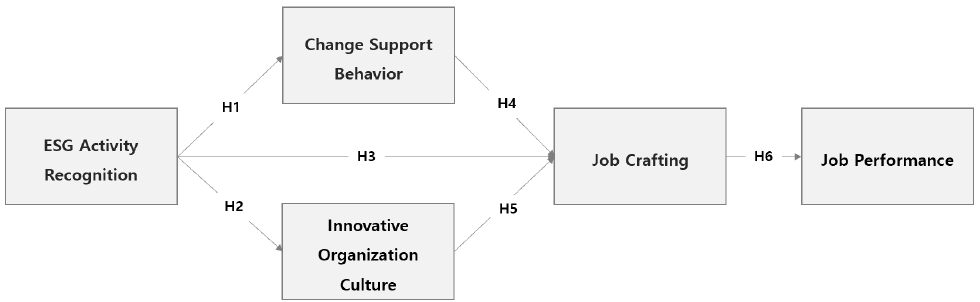
Figure 1. Research